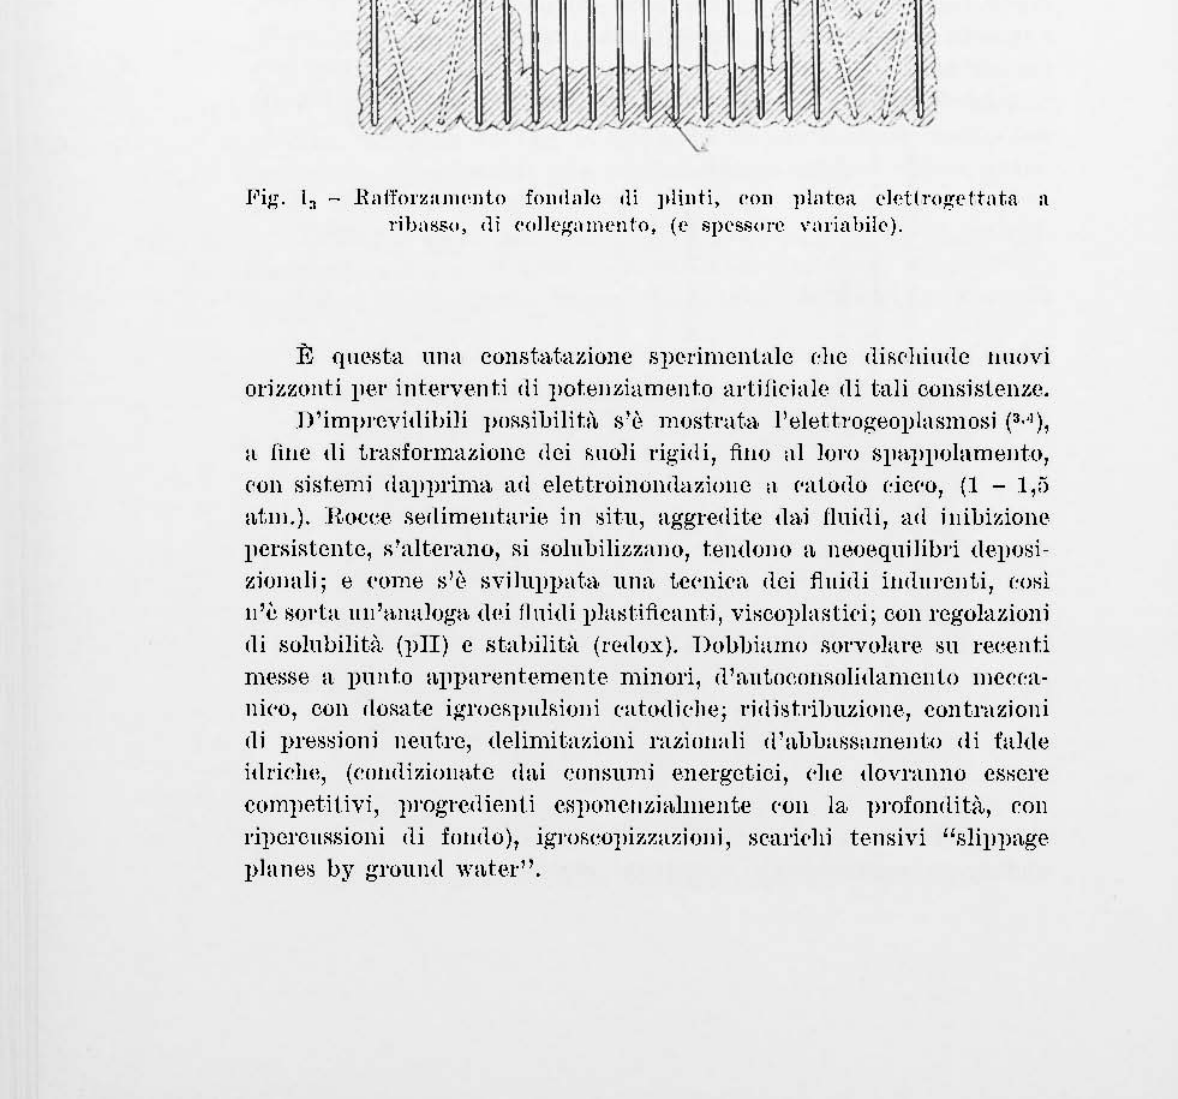
Fig. l, - HaHol'~aJll('nto fondalo ,li plinti, ('on ]l!atea l'leUl'o)!;eltnta n l'ibn~so, ,lì ('o!!eg-nmenl0, (e spessore nU'inhile).